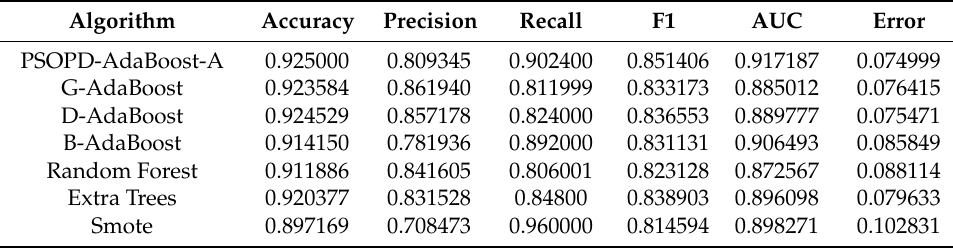
Table 3. Comparison of Classification Results on the Vehicle